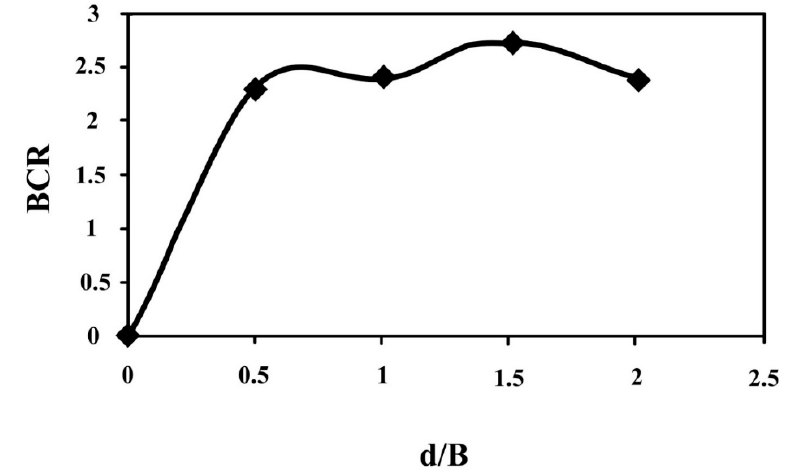
Figure 16. BCR versus the d/B ratio for bamboo-grid-reinforced soil (modified from Mathew and Sasikumar [35]).